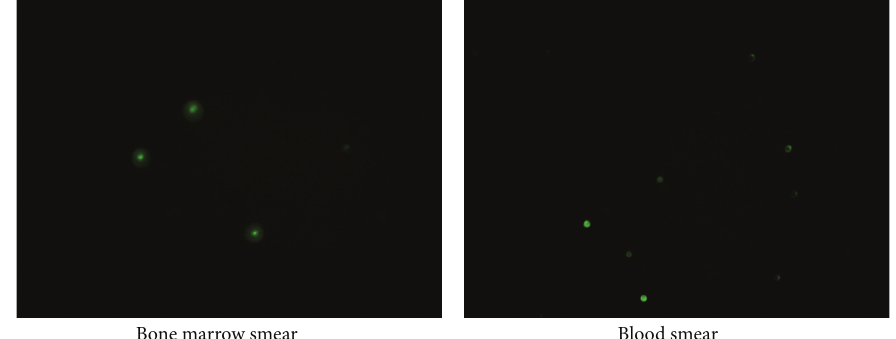
Figure 5: The multiplacentas pooled cells transplanted mice exhibited positive donor cell engraftment at day seven after transplantation